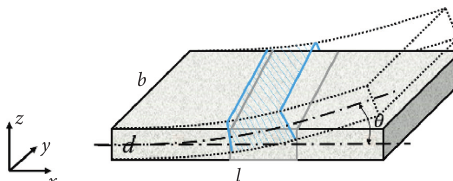
Figure 6: The deformation of the crystal plate under external excitation.